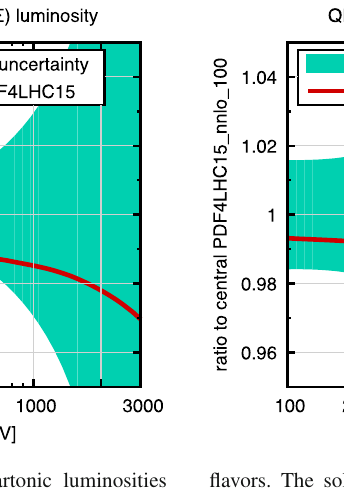
flavors. The solid red lines correspond to the ratio of luminosities obtained with the LUXqed_plus_PDF4LHC15_nnlo_100 [39] and PDF4LHC15_nnlo_100 [33] sets, where a given M / 2 value (cid:31) 1 corresponds roughly to the same p T , Z . The bands represent the dx , M 2 ) f a / p ( x , M 2 ) f b / p ( M 2 (cid:30) M 2 / s x xs PDF4LHC15_nnlo_100 uncertainty, shown for ( L + L ) , while the (cid:30) gq i g ¯ q i i L q i ¯ q i , where i runs over quark i